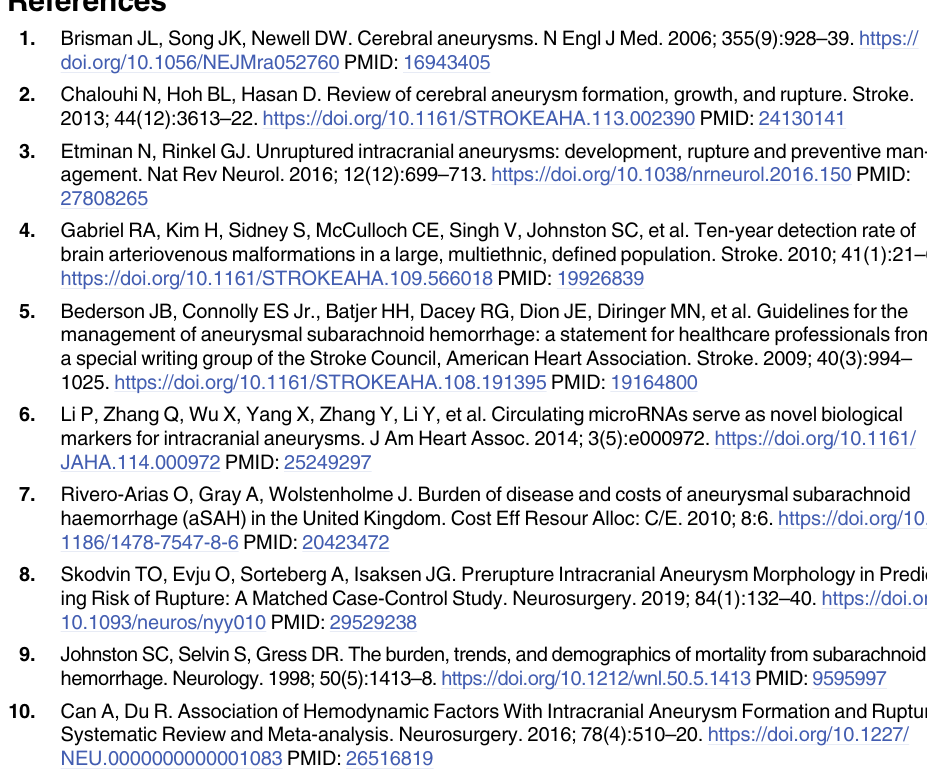
S1 Fig. Directed acyclic graph of biological process (BP) terms. S2 Fig. Directed acyclic graph of cellular compartment (CC)